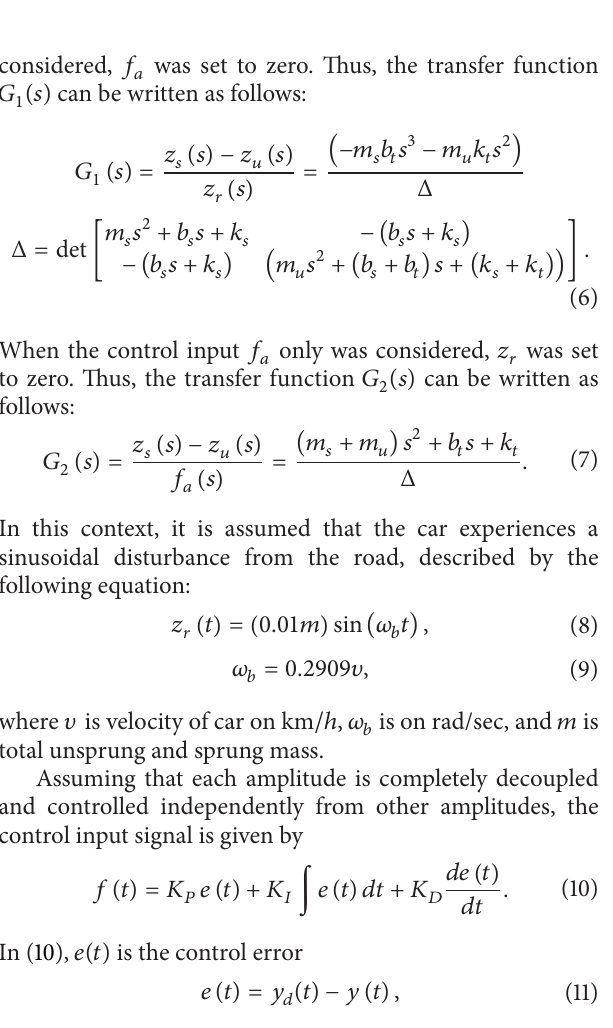
Figure 2: (a) A biological nervous systems and (b) an artificial neuron model.